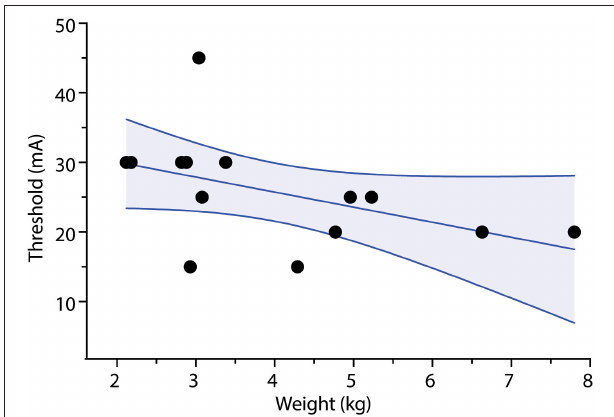
FIGURE 3 | Correlation of stimulus threshold for accelerometry measurement and weight. Stimulus threshold for accelerometry measurement output is negatively correlated with body weight. p < 0.05, Spearman’s correlation test r = − 0.56. Dots represent stimulus threshold required to elicit a train-of-four accelerometry read-out in individual infants. Solid line represents line-of-best-fit; shaded area represents 95% confidence interval limits.